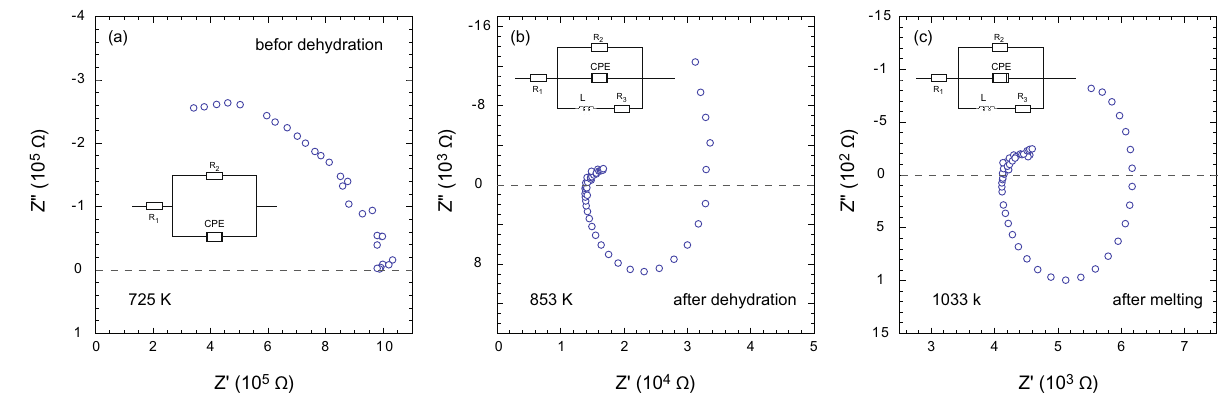
Figure 2. Impedance spectra of the glaucophane at 1.5 GPa. (a) At 725 K, below dehydration temperature of glaucophane (830 K), the impedance arc resembles grain interior processes, which can be modeled with a resistor- constant phase element (R-CPE) circuit. (b) At 853 K, the impedance spectrum shows the development of an inductive loop in response to the dehydration and the presence of fluid in the sample. The equivalent circuit can be represented as an R-CPE with an inductive component (L). The induction at low frequencies can be explained by the adsorption of ionic species in the electrode surface or erosion of electrodes due to fluid phases. (c) Further increase in temperature to 1033 K results in a sudden decrease in sample resistance. The persisting induction loop in impedance spectra indicates a possible reaction of melt with Ni electrodes.